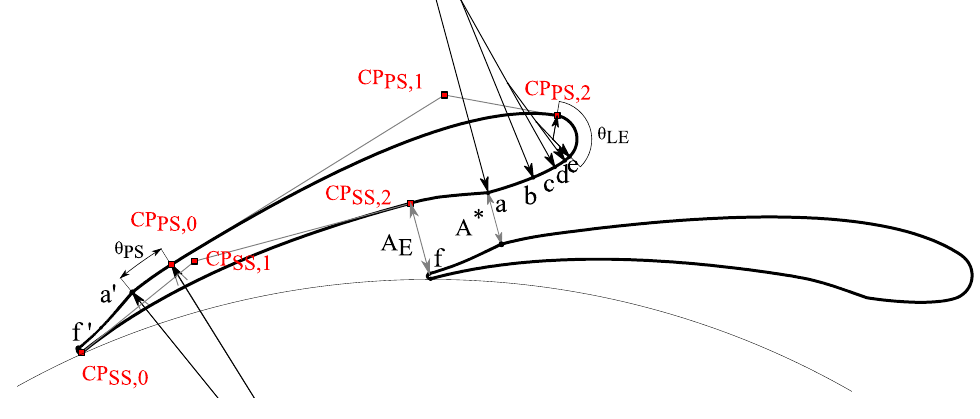
Figure 3. Radial inflow turbine vane parametrization method.